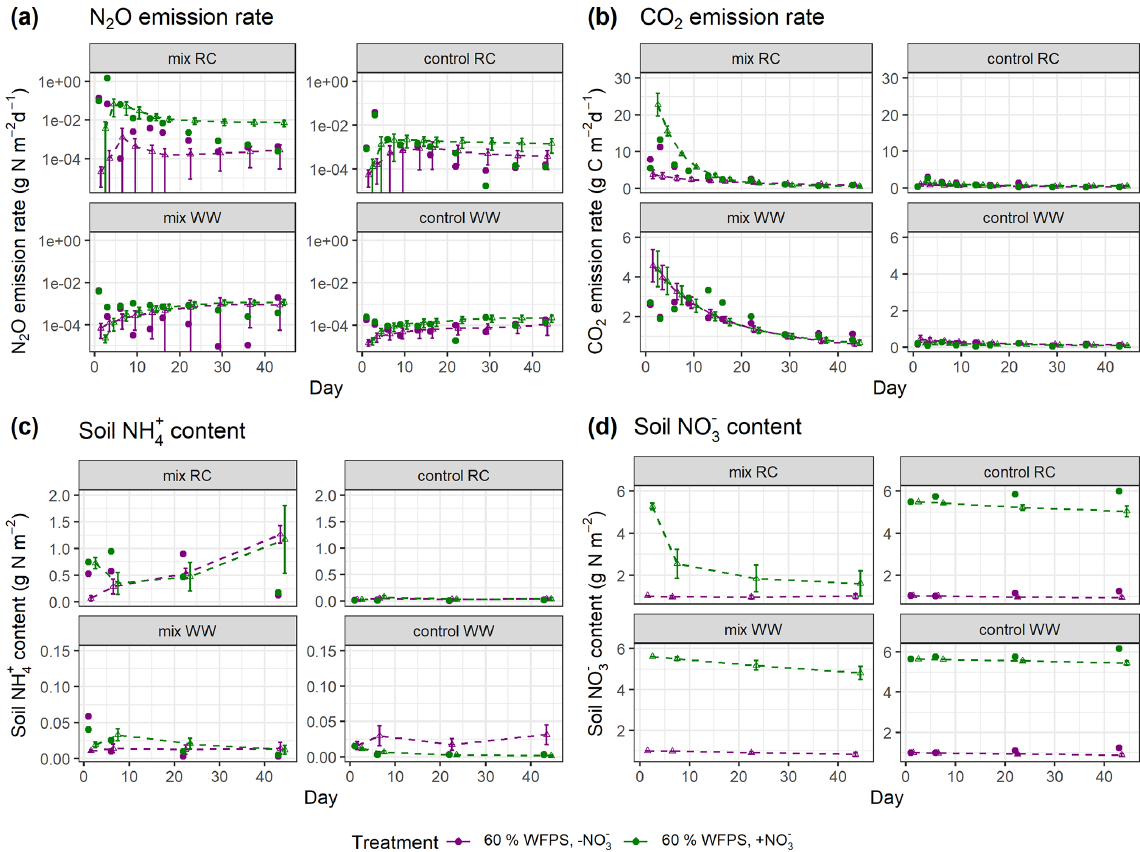
Figure 5. Simulated and measured daily (a) N 2 O fluxes, (b) CO 2 fluxes, (c) soil NH + incubation at 60% WFPS. Scatter points represent measured data, and triangles with dashed lines represent simulated data (error bar: 95% confidence interval). Daily measurements presented were re-calculated from the data provided by Taghizadeh-Toosi et al.